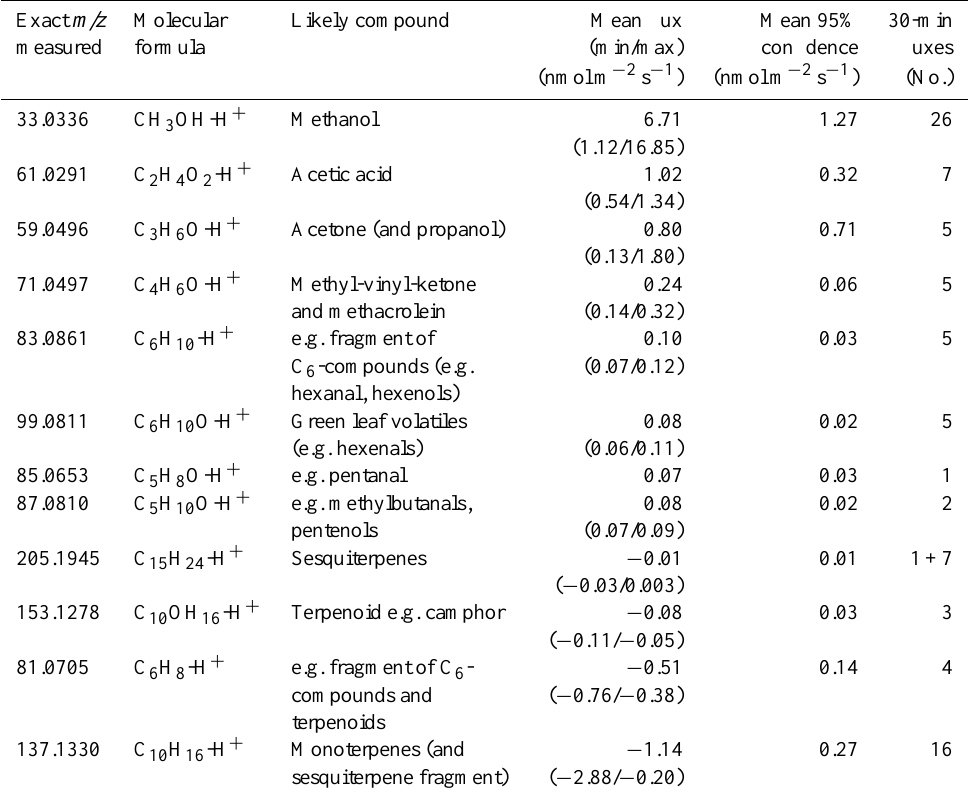
Table 4. VOC fluxes after removal of cut grass during a sunny day between 08:00CET on 7 August and 08:00CET on 8 August in 2009 in Neustift, Stubai valley. Fluxes were calculated from the 30-min concentration and wind covariance and only class-A fluxes, with a well defined maximum or minimum in the covariance, were taken into account. The 95% flux confidence is calculated from the mean noise of class-A fluxes. The No. of 30-min fluxes shows how many class-A fluxes (emission or deposition) were observed, for and sesquiterpenes we give No. of emission+deposition fluxes,